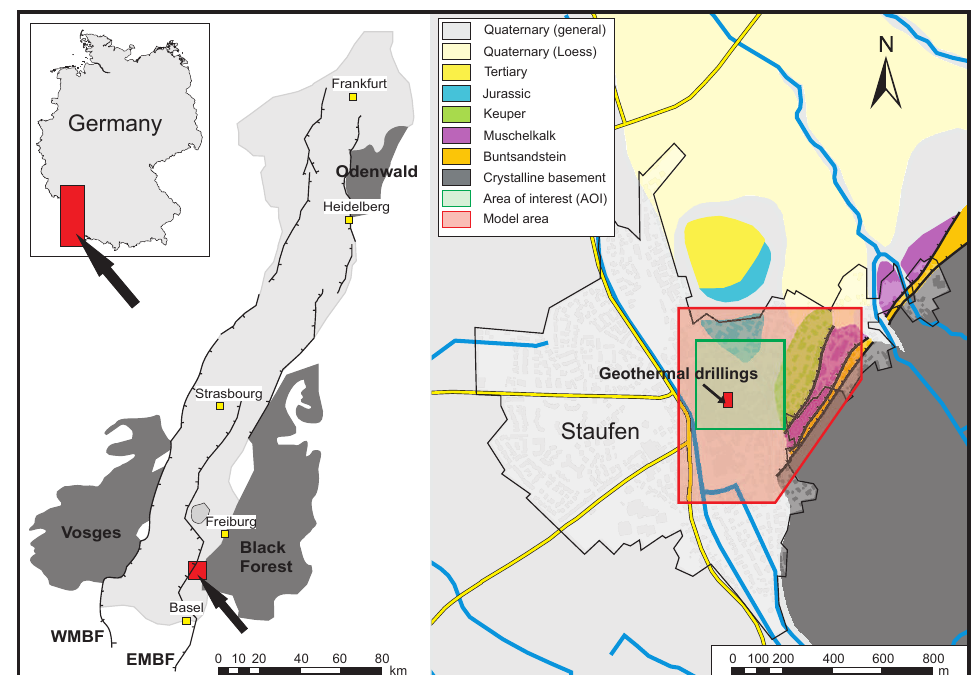
Figure 1. Study site and location of the model area and area of interest